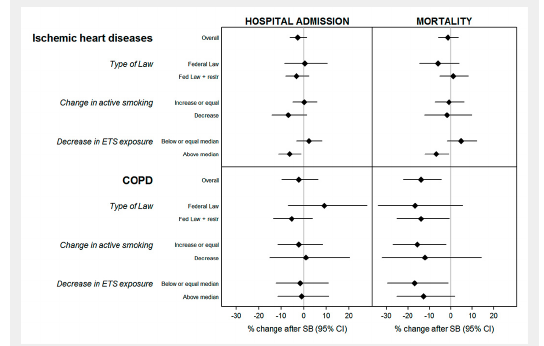
Change (and 95% confidence interval, CI) in hospital admissions and mortality due to ischaemic heart disease and chronic obstructive pulmonary disease (COPD) in adults (≥35 years old) after the introduction of the smoking ban, by type of law and smoking profile of the canton (adjusted for the socioeconomic and health profile of the